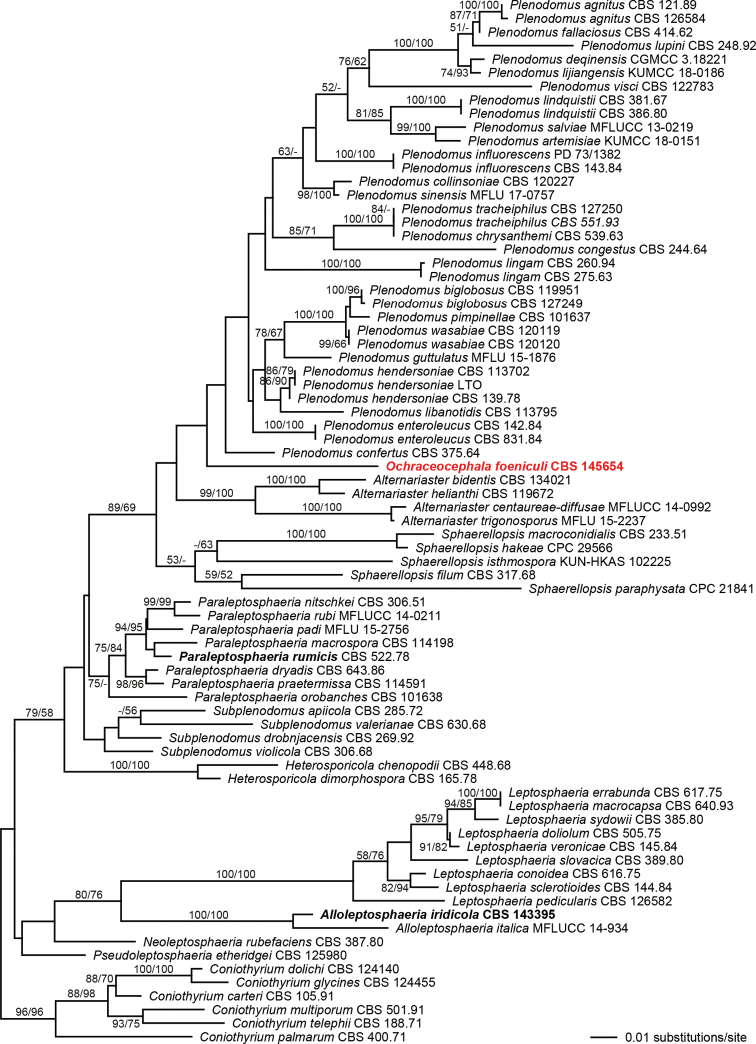
Phylogram of the best ML tree (–lnL = 14211.5558) revealed by RAxML from an analysis of the combined SSU-ITS-LSU matrix of selected Leptosphaeriaceae, showing the phylogenetic position of Ochraceocephala
foeniculi (bold red). Taxa in bold black denote new combinations proposed here. ML and MP bootstrap support above 50% are given above or below the branches.